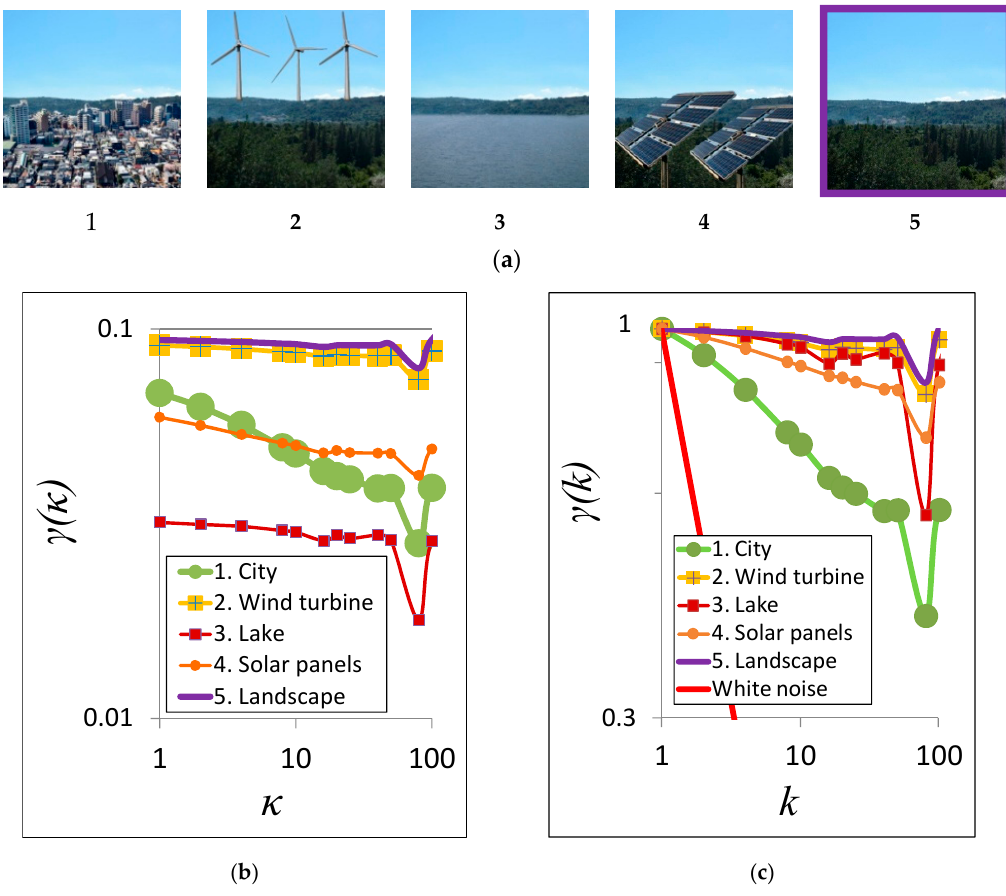
Figure 6. ( a1 – a4 ) Transformed landscape ( a5 ) Original landscape ( b ) climacograms of images ( a1 – a5 ) ( c ) standardized climacograms of images ( a 1– a5 ) .